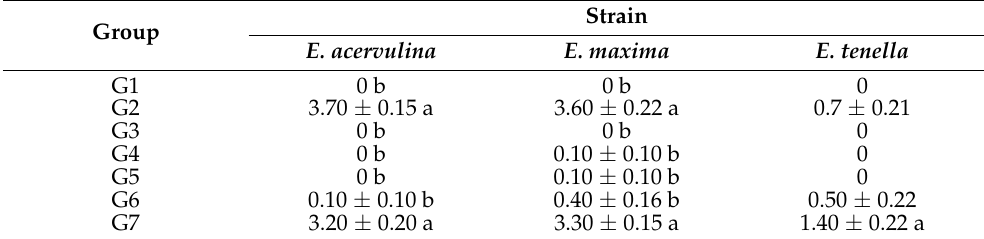
Table 3. Scores of Eimeria species-specific lesions of chickens prophylactically treated with toltrazuril formulations.